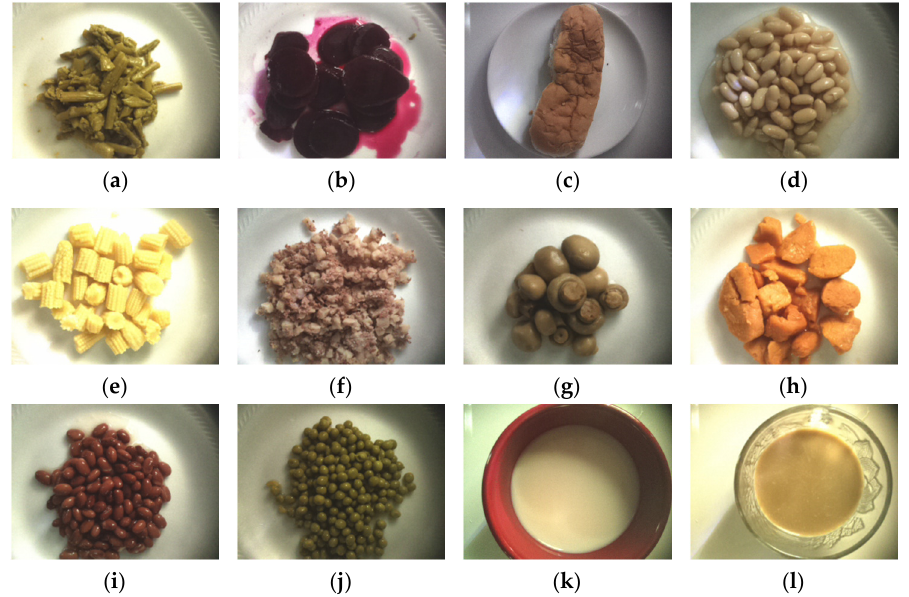
Figure 9. Screenshots of the GUI: ( a ) default screen shown when idle; ( b ) Classify window showing the captured image, item name, and target temperature; ( c ) New item window showing textboxes to enter item name and target temperature by the user; ( d ) Heating window showing real-time thermal image, item name, target temperature, and current food temperature.